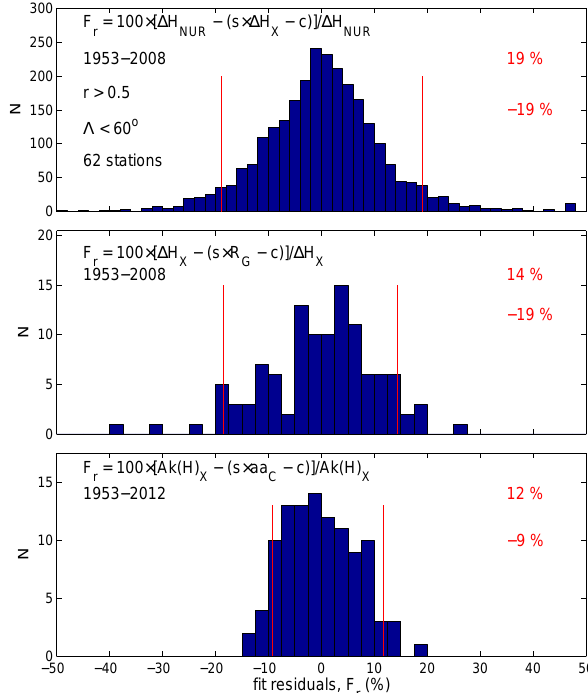
Fig. 4. Distributions of percentage, linear-regression fit residuals. (Top panel) For the linear regression fits of 1H X (where X is the observatory code), to 1H NUR for the 62 variations shown in Fig. 3. (Middle panel) For the linear regression fits of group sunspot number to the 1H NUR and 1H ESK variations. (Bottom panel) For the linear regression fits of the aa range index to Ak ( H) NUR and Ak ( H) ESK . In each panel the vertical, red lines give the 5th and 95th percentiles of the distribution, the values of which are given in